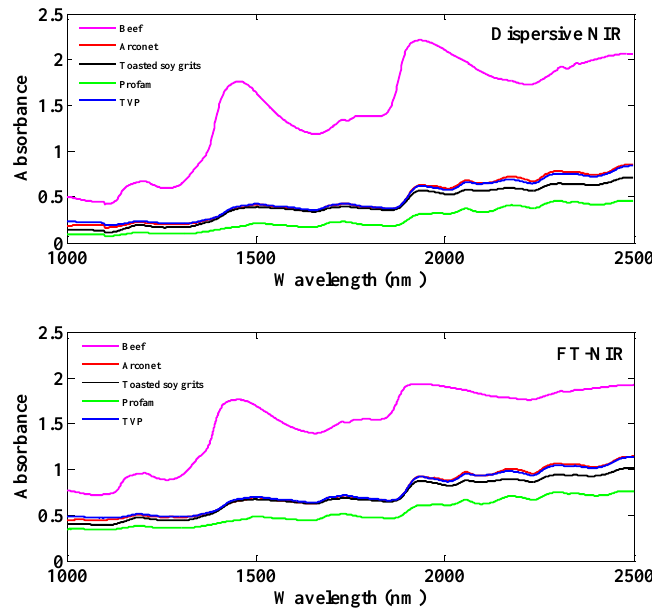
Figure 2. Dispersive NIR and FT-NIR spectra of ground beef (0%) and soy samples (100%) in the region of 1000–2500 nm.